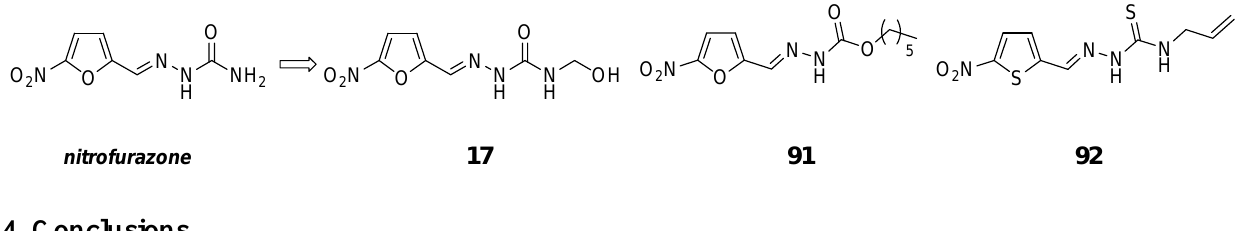
Figure 6. 5-Nitrofuran and 5-nitrothiophene derivatives without mutagenic effects (Ames test).